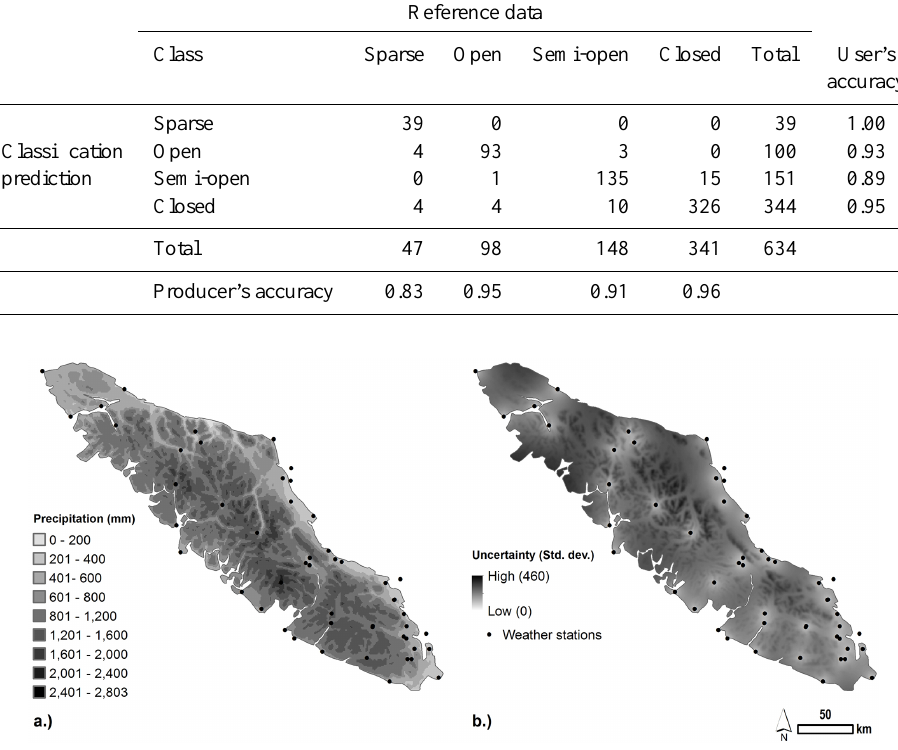
Figure 3. A map of interpolated 2-week antecedent precipitation (a) and a map of interpolation uncertainties expressed by the kriging prediction standard deviation (b) .